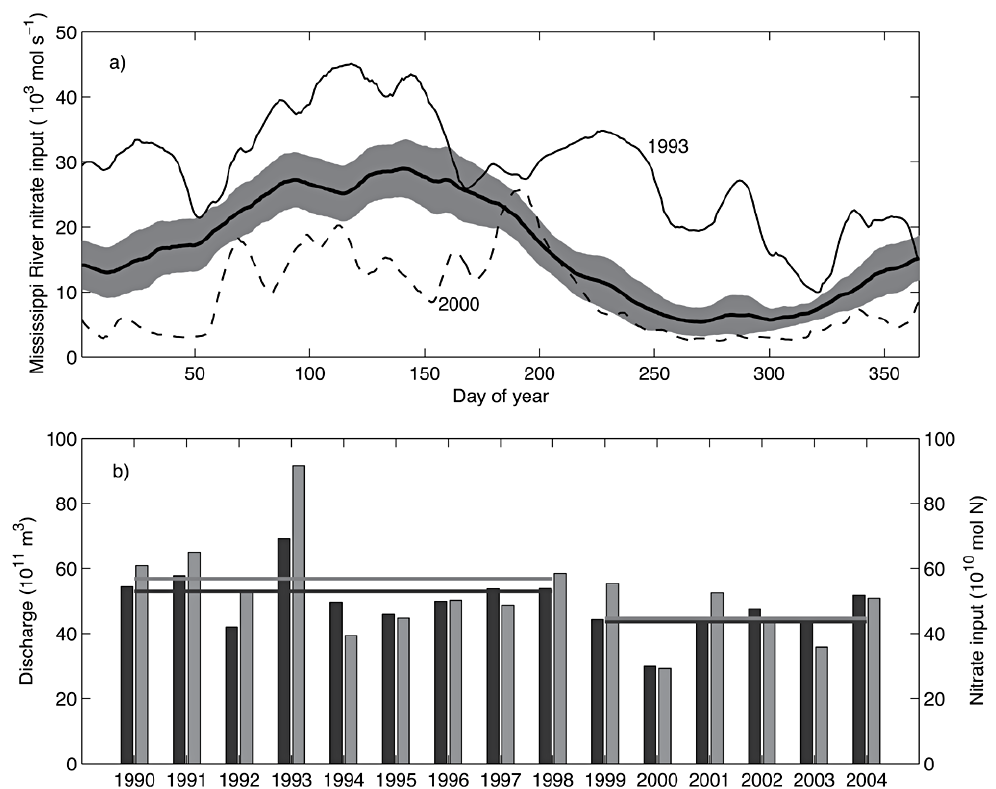
Fig. 3. (a) Climatological daily nitrate input from the Mississippi River (thick black line) and one standard deviation (gray area) for the period from 1990 to 2004. The daily nitrate input is also shown for the years of highest (1993, solid black line) and lowest (2000, dashed line) discharge. (b) Annual means of Mississippi River freshwater discharge (dark gray bars) and nitrate input (light gray bars). Mean freshwater discharge and nitrate input was lower for the years 1999 to 2004 with an average of 4.4 × 10 11 m 3 yr − 1 and 4.5 × 10 10 molN − 1 yr − 1 , respectively, than during the years 1990 to 1998 with 5.3 × 10 11 m 3 yr − 1 and 5.7 × 10 10 molN − 1 yr − 1 . Average annual discharges for both periods are shown as solid horizontal